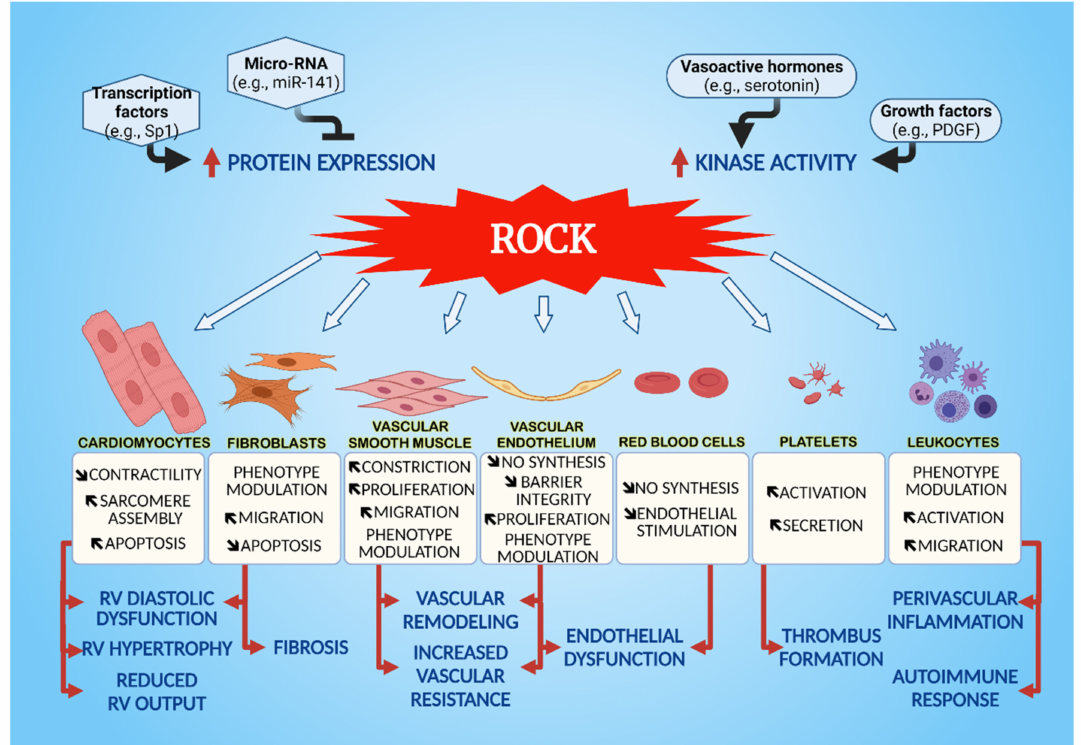
Figure 1. Influence of ROCK overexpression and activation on the main cellular effects contributing to PH